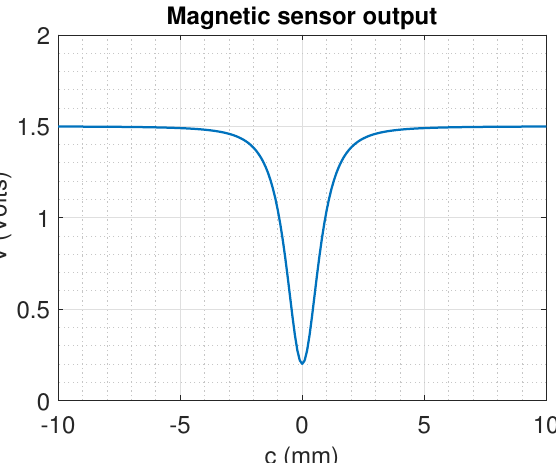
Figure 4. DRV5053VAQDBZR voltage output expected for each sensor based on the distance over the linear shaft movement